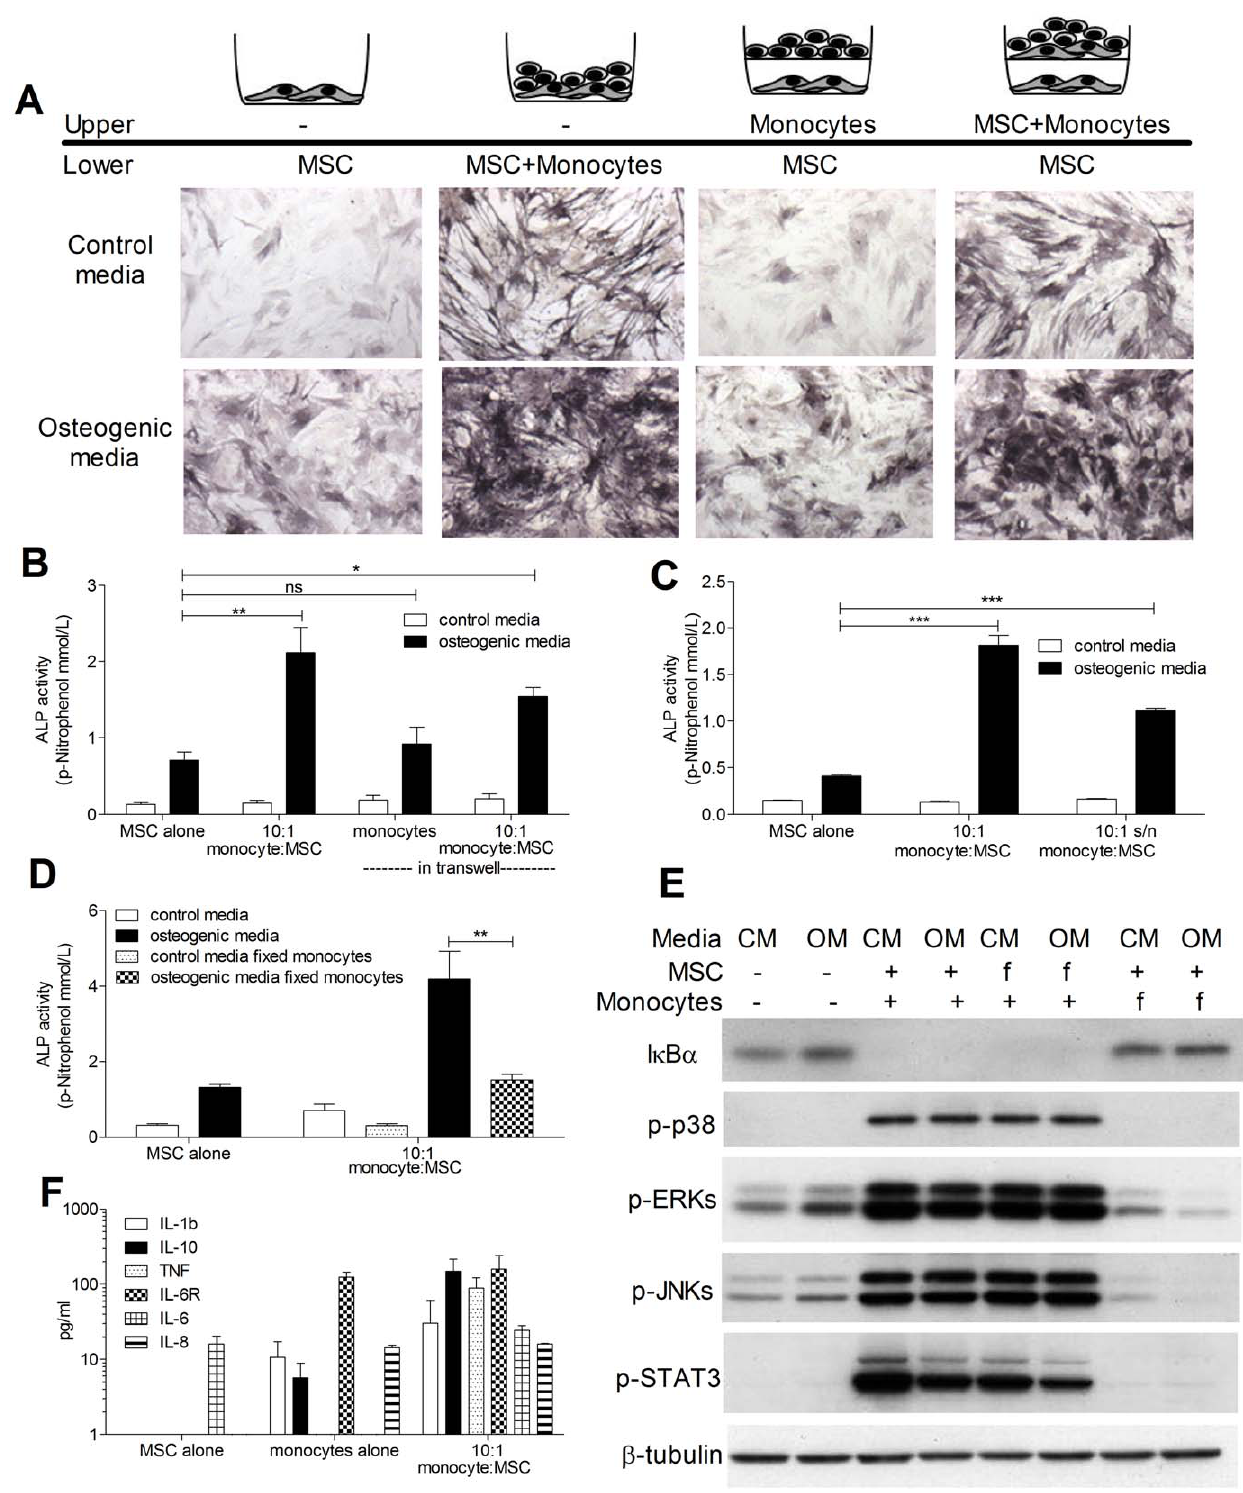
Figure 2. Osteogenic induction requires cell contact and monocyte-derived soluble factors. MSCs were cultured either alone, with 10:1 monocytes in contact, with monocytes separated by a 0.4 m m pore size cell culture insert (upper chamber) or with a co-culture of 10:1 monocyte:MSC in the cell culture insert (upper chamber), in the presence or absence of osteogenic stimuli. After 7 days, MSC ALP was assessed by staining (A) and quantification of enzyme activity (B). ALP activity induced by 10:1 monocyte:MSC co-cultures was compared to that induced by treatment with supernatant from co-cultures incubated for 24 hours (10:1 s/n) (C). ALP activity of MSCs was also measured after 7 days of co-culture with either fresh of fixed monocytes (fixed in 0.05% glutaraldehyde for 1 min followed by 1 min in 0.2 M glycine) (D). MSC were treated for 30 mins with supernatant from monocyte:MSC co-cultures or monocyte:MSC co-cultures where either monocytes or MSCs had been fixed (f), in control media (CM) or in